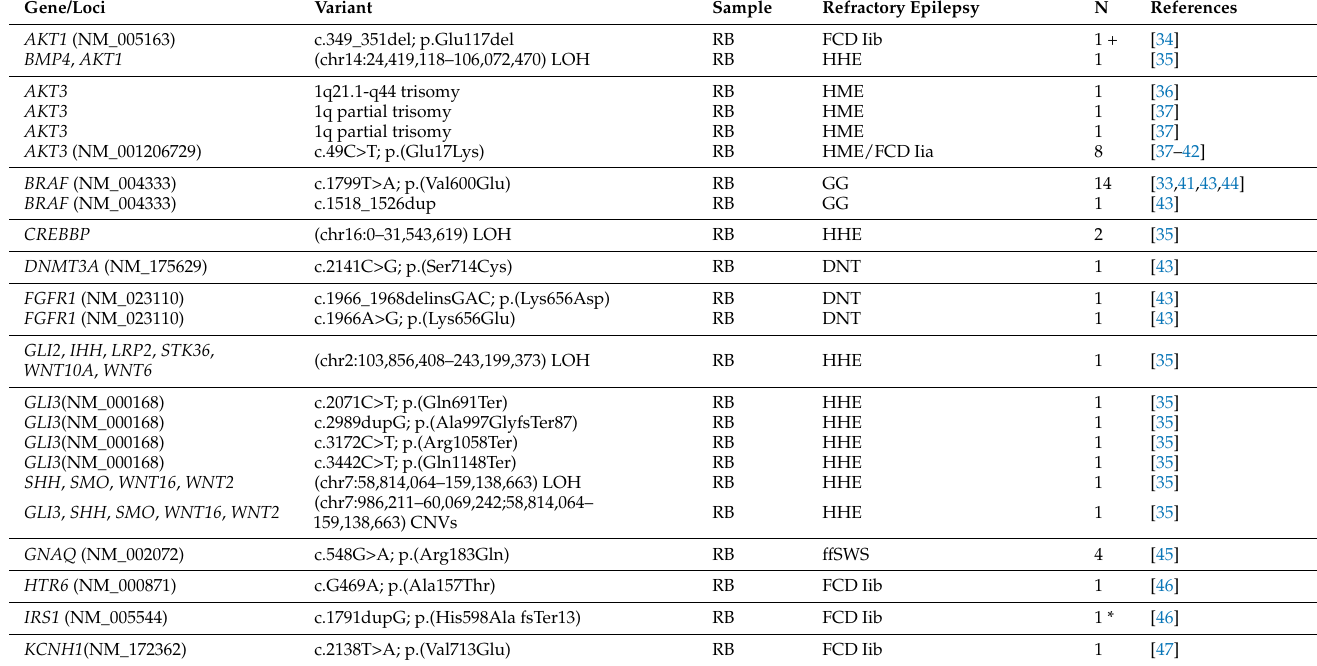
Table 1. Review of brain somatic pathogenic variants detected in refractory-epileptic